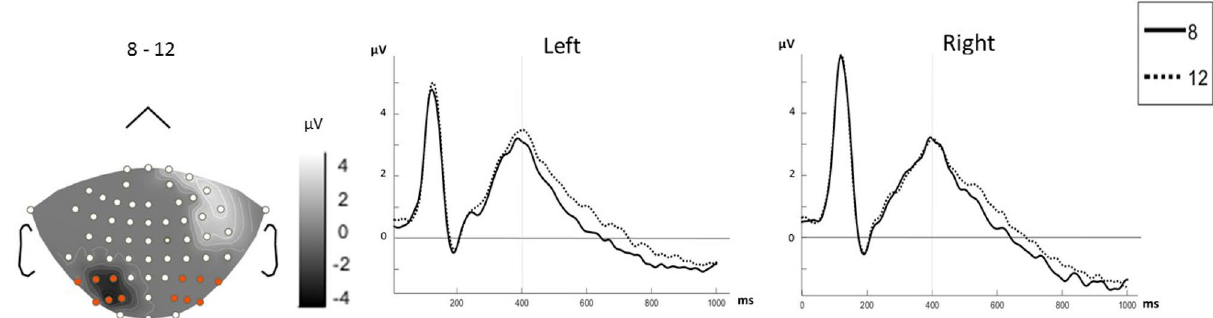
Figure 4. The effect of magnitude on ERP results . Left: topographic plot of time interval with significant difference (400–1000 ms) according to t -test (after FDR correction) considering magnitude condition. 6 electrodes over right and left parietal areas were entered into the analysis. Right: time domain ERP averaged from electrodes over left parietal (left chart) and right parietal (right chart) showing significant magnitude. The vertical line at 400 ms marks the start of the analyzed time